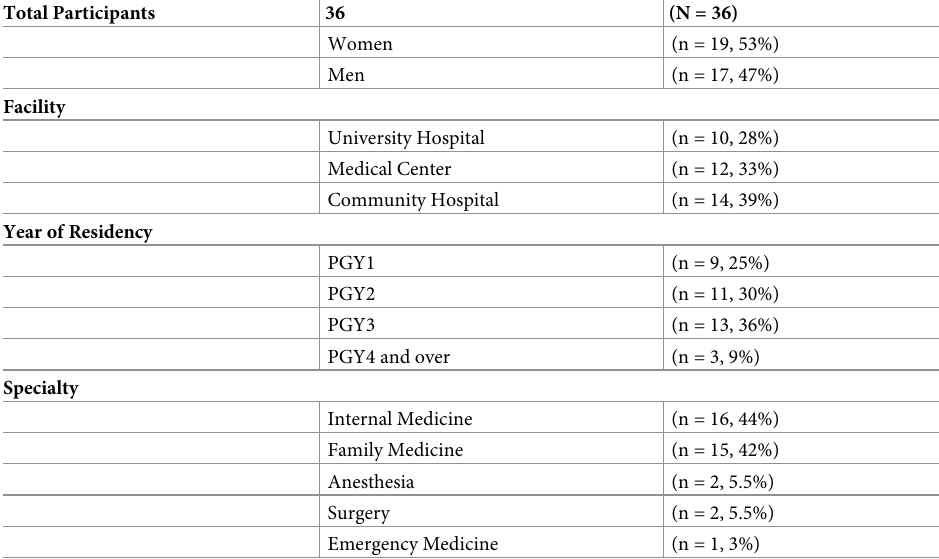
Table 3. Participants’